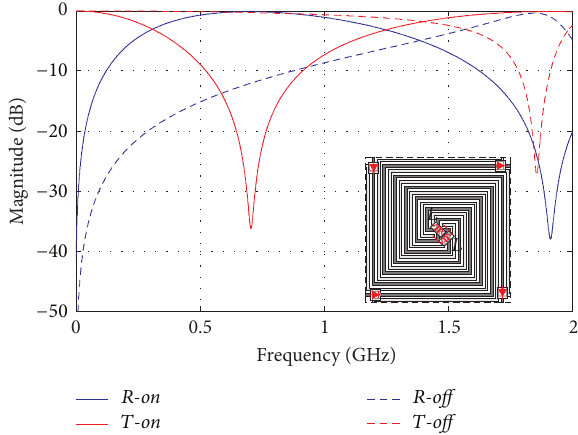
Figure 11: Transmittance and reflectance at normal incidence of the AFSS with the unit cell of Figure 8 when pin diode switches are in the on (solid lines) and off (dashed lines) states.